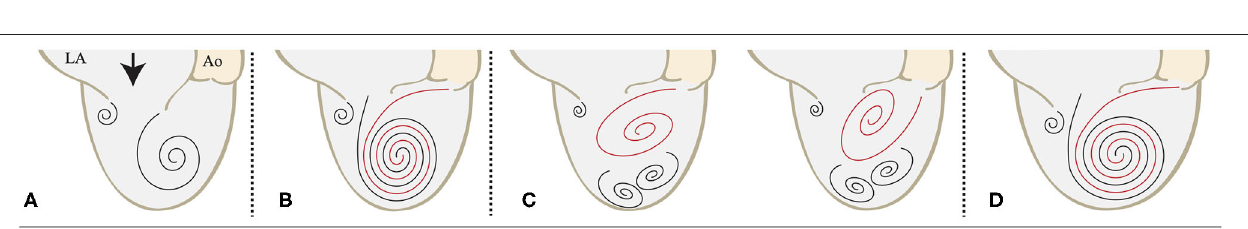
FIGURE 4 | Schematics of LV vortex interaction in diastole. (A) The intramitral flow organizes itself in a circulatory pattern that redirects the flow to the aorta. (B) The AR jet collides with the transmitral flow and merges with it. (C) The AR jet inhibits the formation of the optimal left ventricular vortex. (D) The LV cavity is enlarged, and the AR jet and the transmitral flow merge. Abbreviations: AR, aortic regurgitation; LA, left atrium; Ao, aorta; LV, left